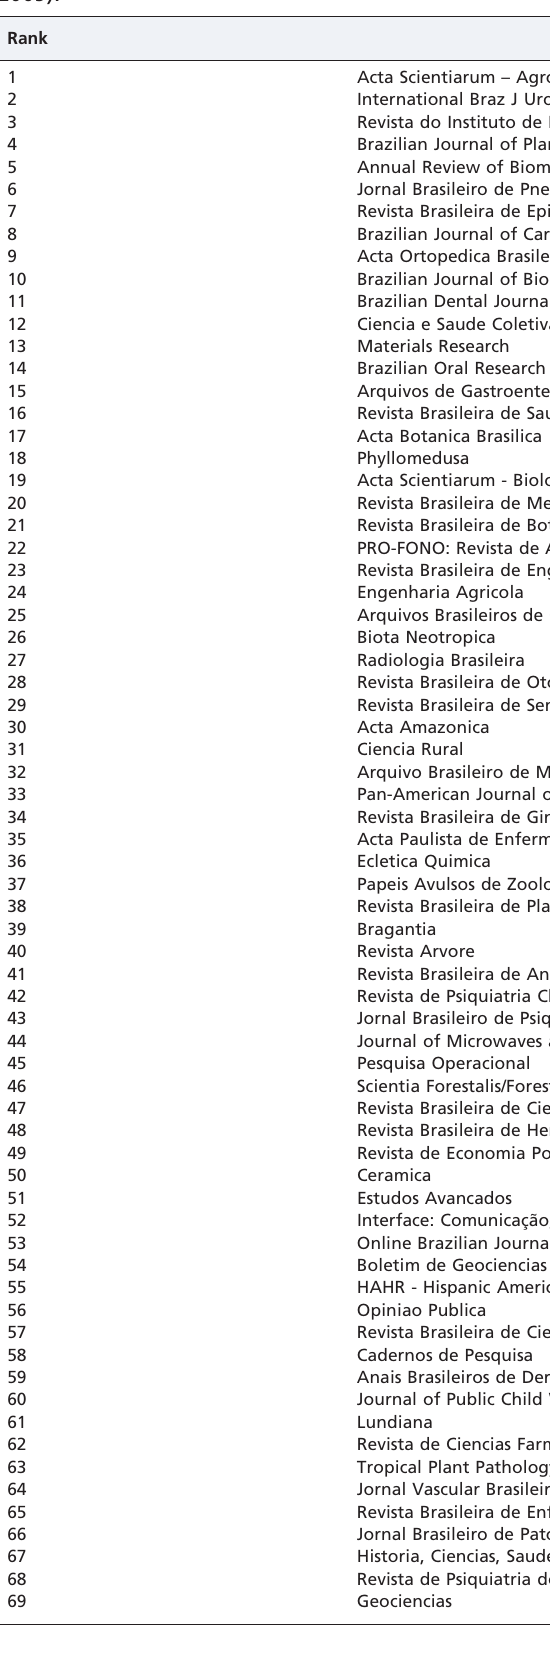
Tabela 1 - Cento e trinta e oito perio´dicos brasileiros excluı´dos do QUALIS com Fator de Impacto SCIMAGO (simulac¸a˜o